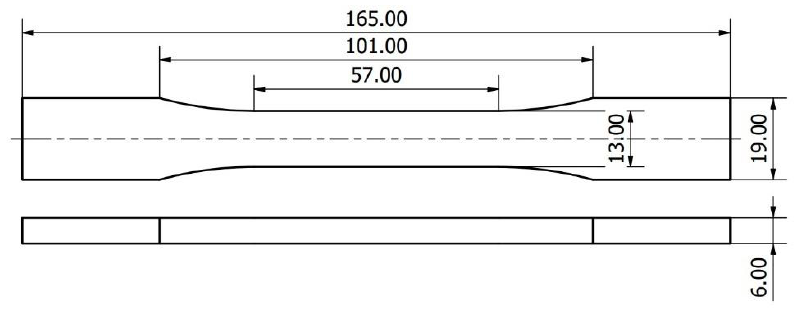
Figure 1. Specimens ’ dimensions and shape. Figure 1. Specimens’ dimensions and shape.